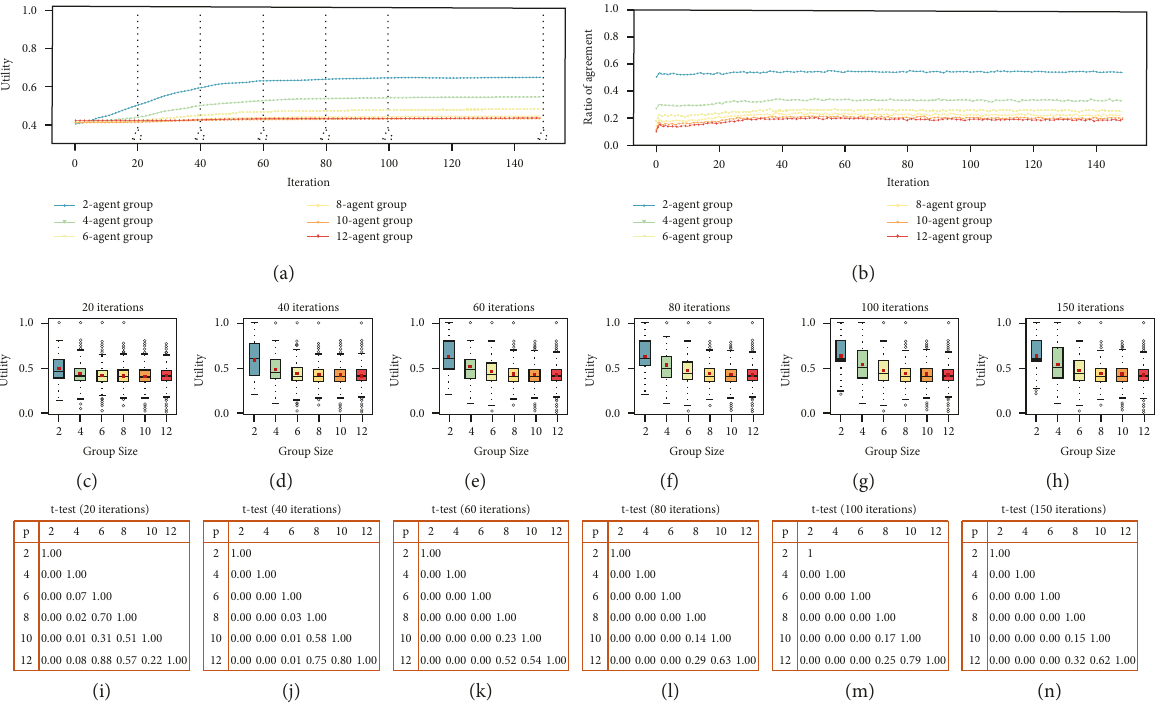
Figure 7: Change of utility of group solution (500 independent Monte Carlo experiments) and the ratio of agreement (500 independent Monte Carlo experiments) over iteration (discussion time) on 15-peak problem